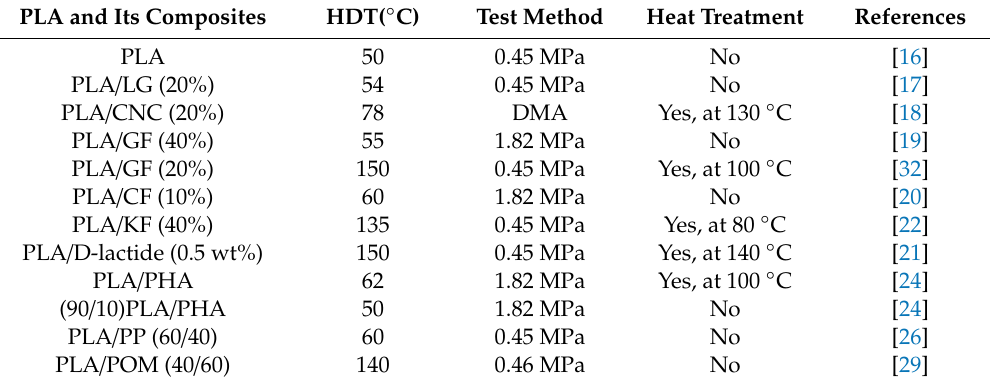
Table 1. Research progress on the heat deflection temperature (HDT) of polylactic acid (PLA). PLA and Its Composites